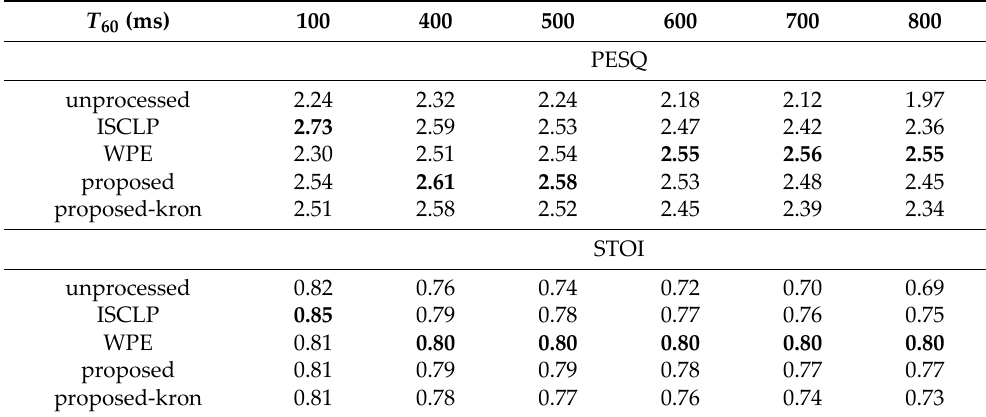
Table 4. Comparison of the test results at 10 dB for babble noise. (The bold in the table indicates the best